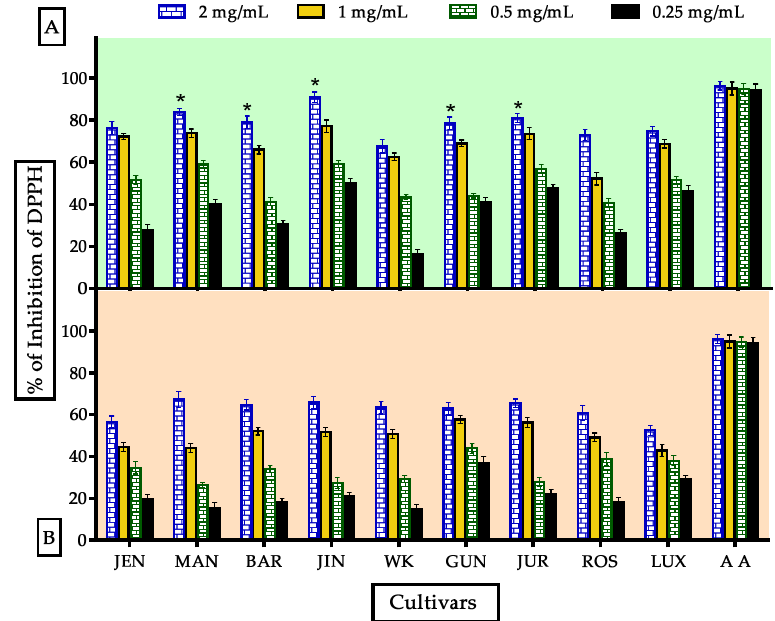
Figure 5. Antioxidant activity of unprocessed and processed lupin flours assayed by DPPH scavenging method; nine cultivars vs. ascorbic acid (standard). ( A , B ), indicated DPPH radical scavenging activity of unprocessed and processed flours respectively. Data were stated as mean ± SEM where n = 3 (* Significance at p < 0.05 vs. standard: ascorbic acid).